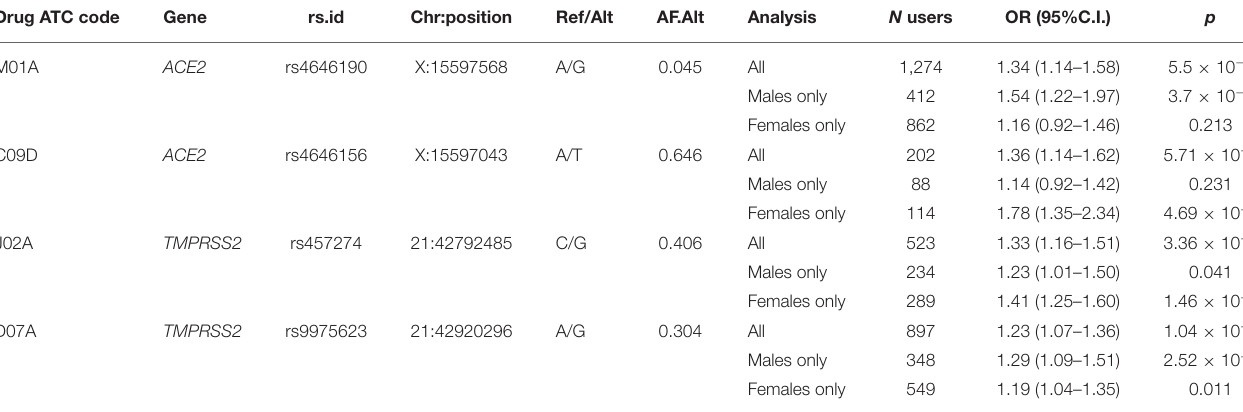
TABLE 2 | Most-significant associations with medications use at ACE2 and TMPRSS2 loci. Drug ATC code Gene rs.id Chr:position Ref/Alt AF.Alt Analysis N users OR (95%C.I.) M01A